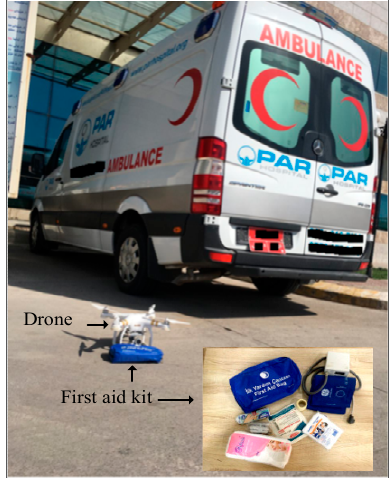
Figure 9. Time response experiment comparing the UAV and ambulance.